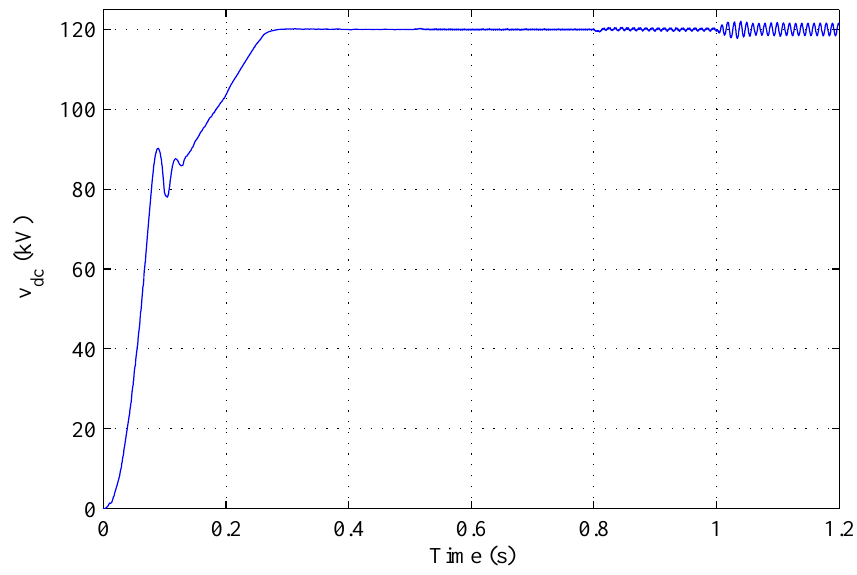
Figure 14. Voltage in the DC